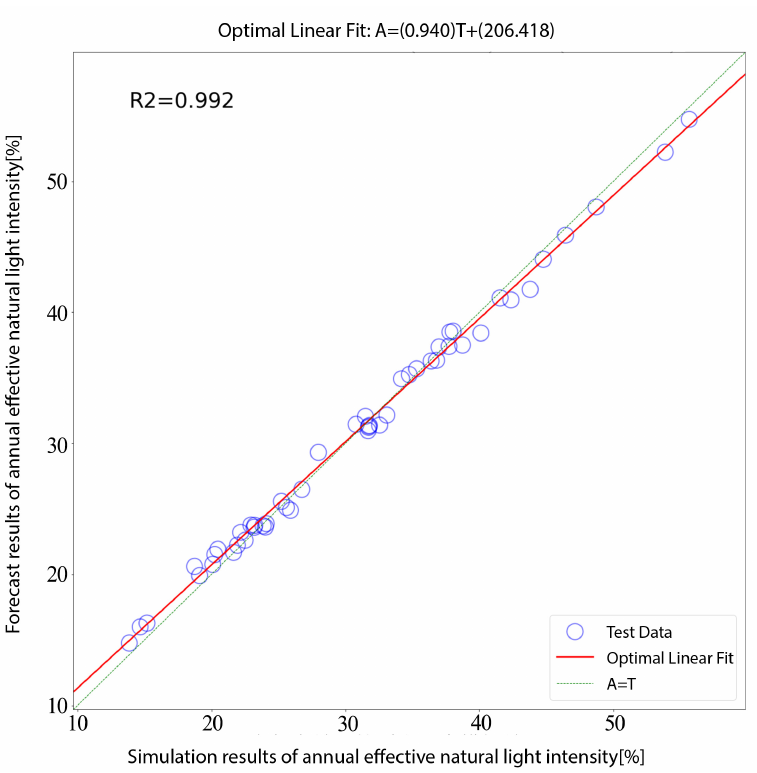
Figure 17. Prediction model of indoor lighting environmental